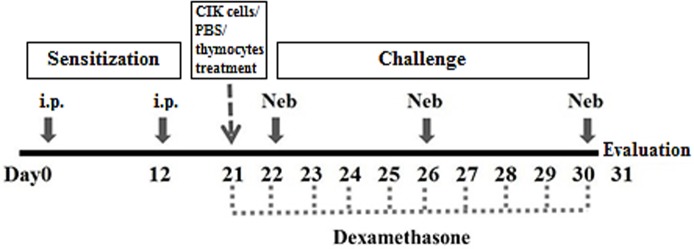
A diagram of the protocol for the mouse model of allergic airway inflammation and CIK cells treatment.C57BL/6 mice were sensitized with an intraperitoneal (i.p.) injection of 50 μg ovalbumin and 25 μg Alum on days 0 and 12. On days 22, 26 and 30, mice were challenged with 2% OVA aerosol (w/v) in saline (Neb) for 30 min. For treatments, 1x107 of CIK cells, PBS or thymocytes were transferred via tail vein on day 21, and 2mg/kg/day dexamethasone was injected i.p. from day 21 to 30. All mice were evaluated 24 h after last challenge.